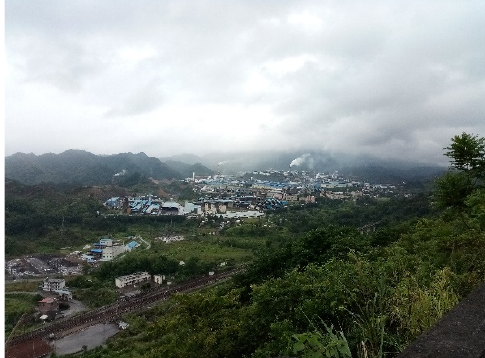
Figure 2. Smelter emission in the research area. Table 1. Geochemical characteristics of heavy metal flux in atmospheric dust (g/hm 2 /a; n = 10).